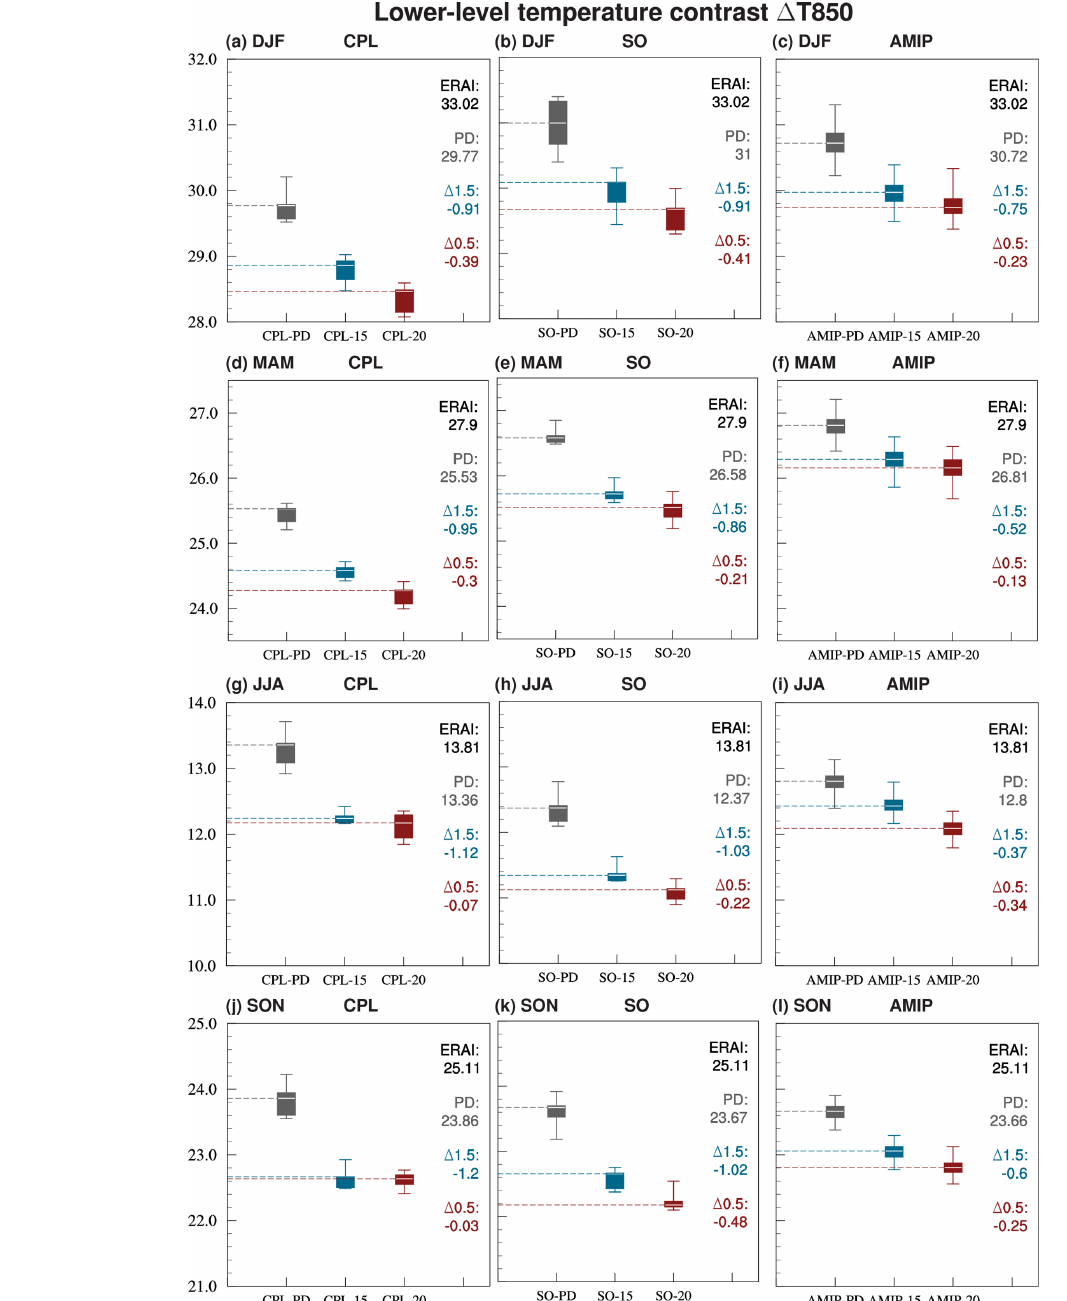
Figure 11. As in Fig. 10 but for the lower tropospheric temperature contrast at 850hPa ( (cid:49)T 850 ).